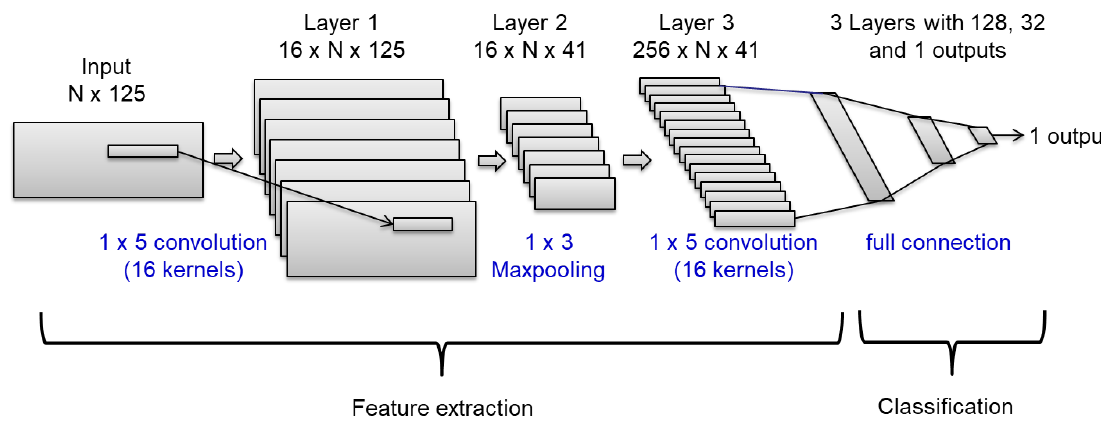
Figure 3. Deep learning structure including convolutional and fully connected layers.